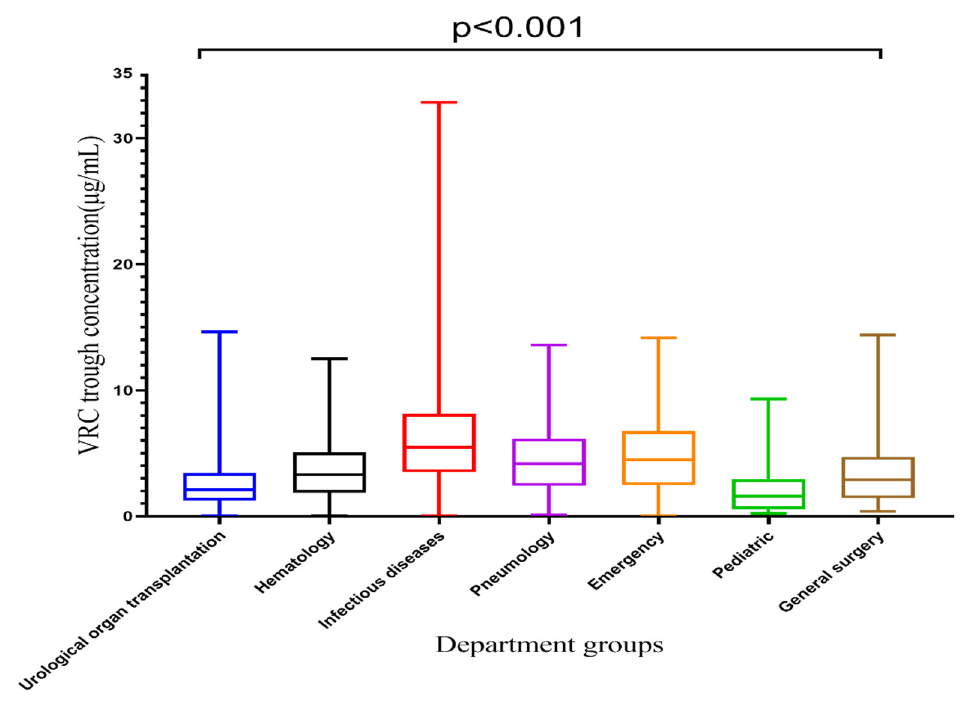
Figure 3. Box plot of VRC trough concentration categorized by department, which is represented by median, minimum, maximum, and interquartile